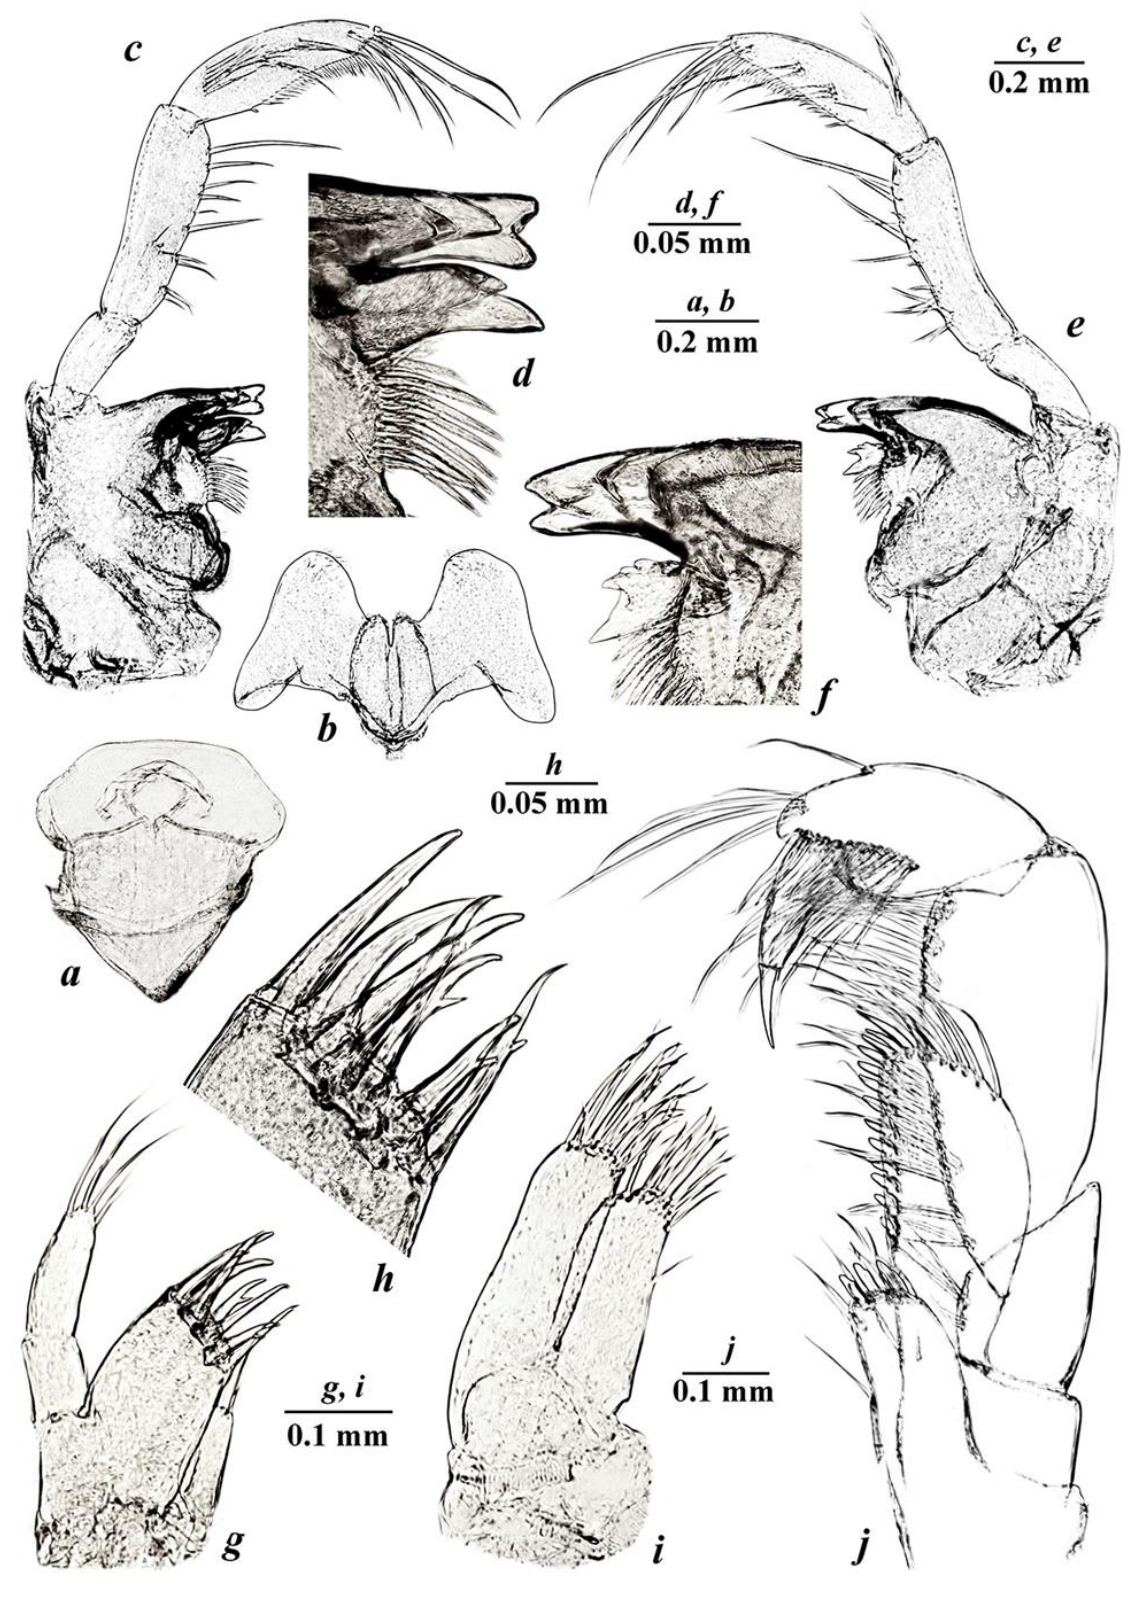
Figure 4. Niphargus tarkhankuticus sp. nov., male: ( a ) labrum (upper lip); ( b ) labium (lower lip); ( c , e ) mandible; ( d , f ) incisor process and pars incisiva of mandibles; ( g ) maxilla I; ( h ) same, distal margin of outer lobe; ( i ) maxilla II; ( j )